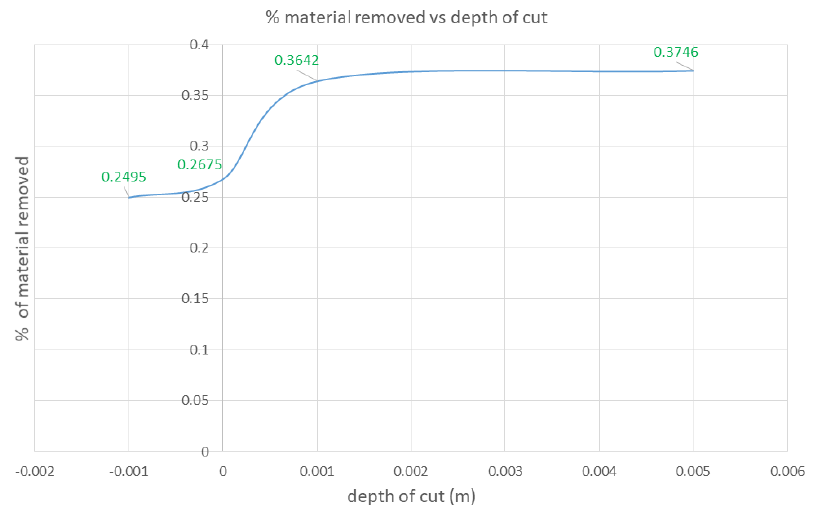
Figure 17. Results of increasing depth of cut on the amount of material removed.